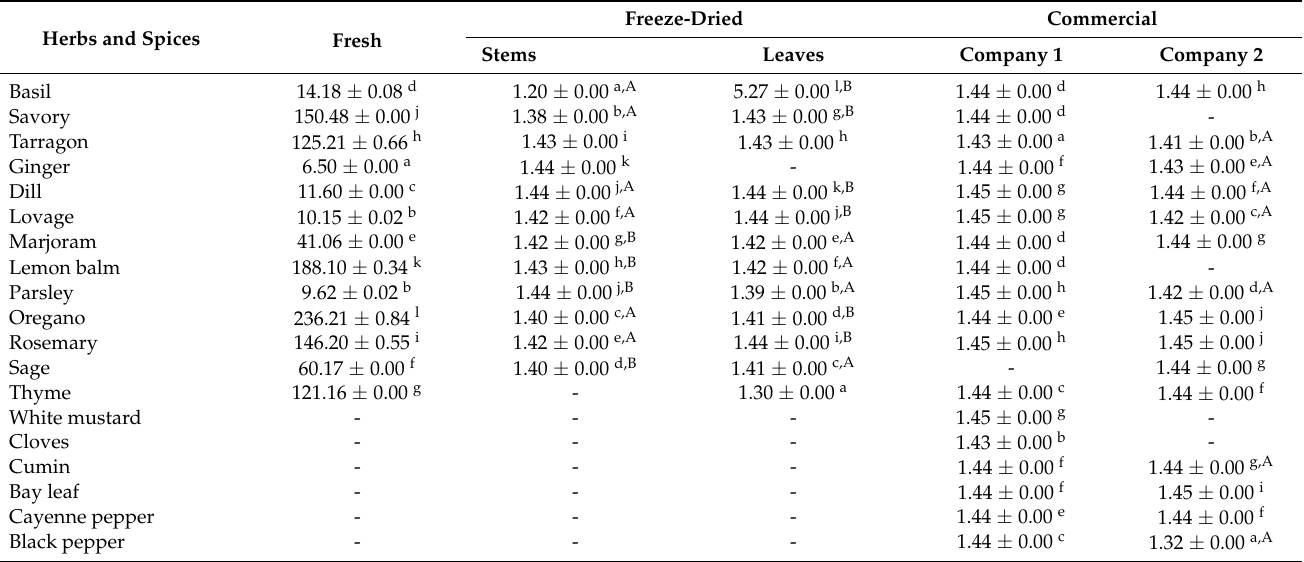
Table 2. Antioxidant activity of herbs and spices, measured by the ABTS method ( µ M